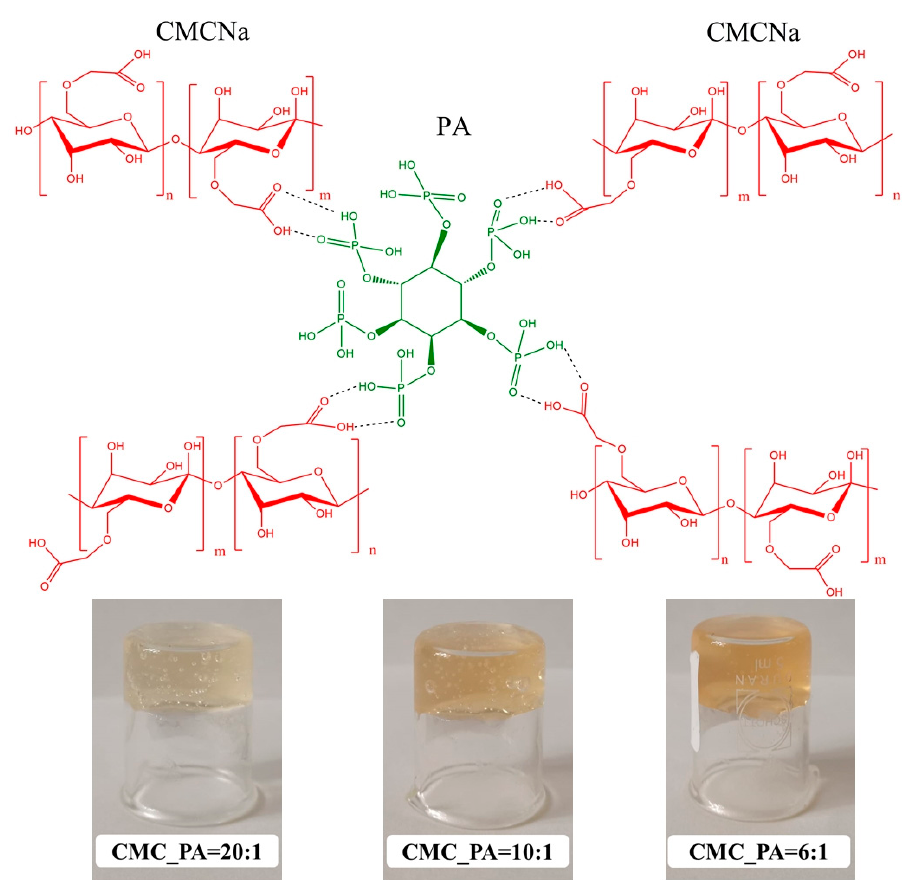
Figure 1. Schematic illustration for the formation of CMC/PA hydrogels and the inverted vial test.